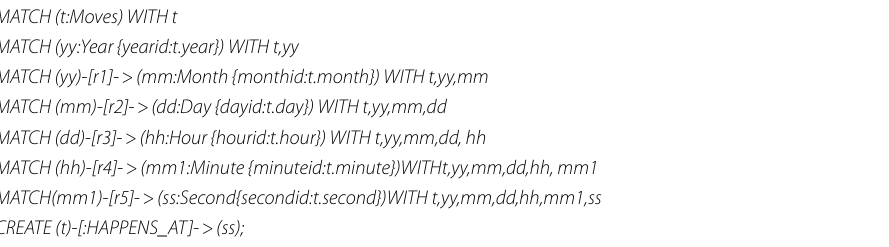
Table 5 Sequential connection of the moves nodes to the time-graph MATCH (t:Moves) WITH